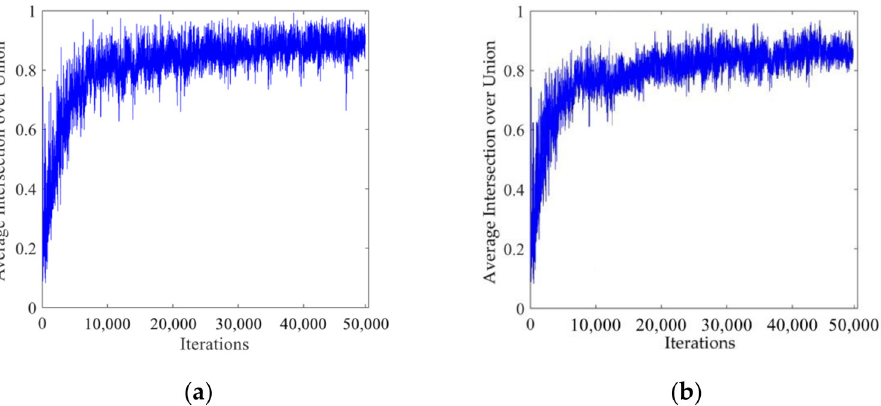
Figure 8. Relation curve of the average intersection over union and the number of iterations. ( a ) LISA traffic light data set. ( b ) LaRa traffic light data